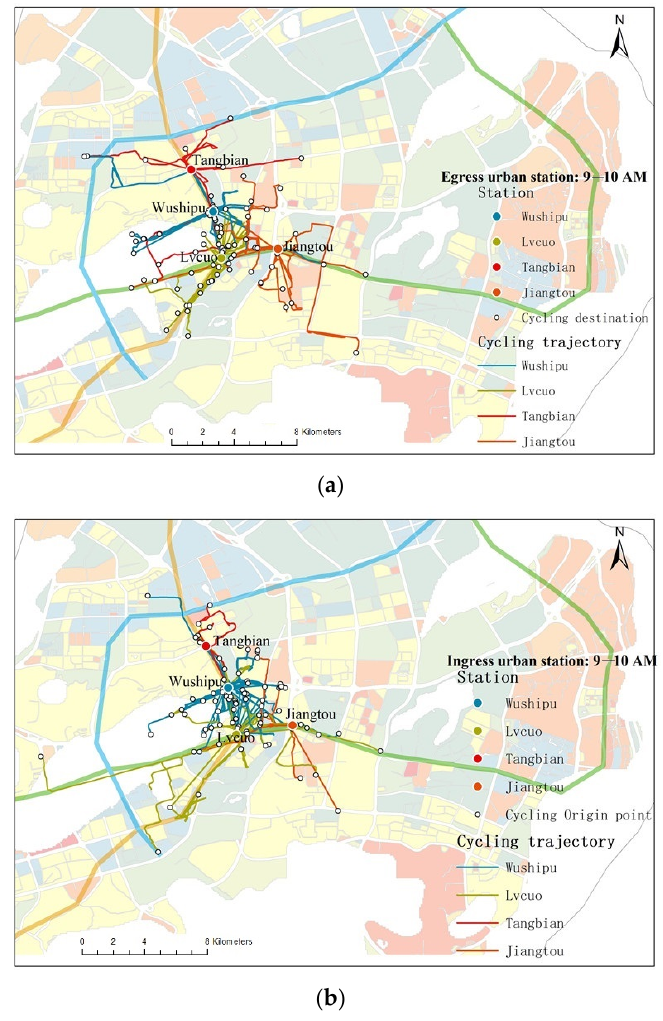
Figure 11. ( a ) Cycling trajectory for egress metro station from 9:00 to 10:00 a.m. ( b ) Cycling trajectory for ingress metro station from 9:00 to 10:00 a.m.